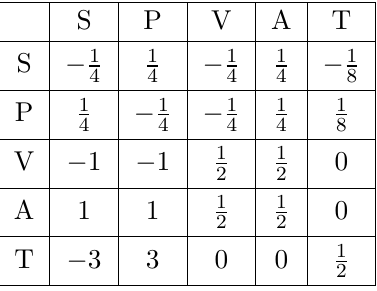
[ (cid:13) (cid:22) ; (cid:13) (cid:23) 2